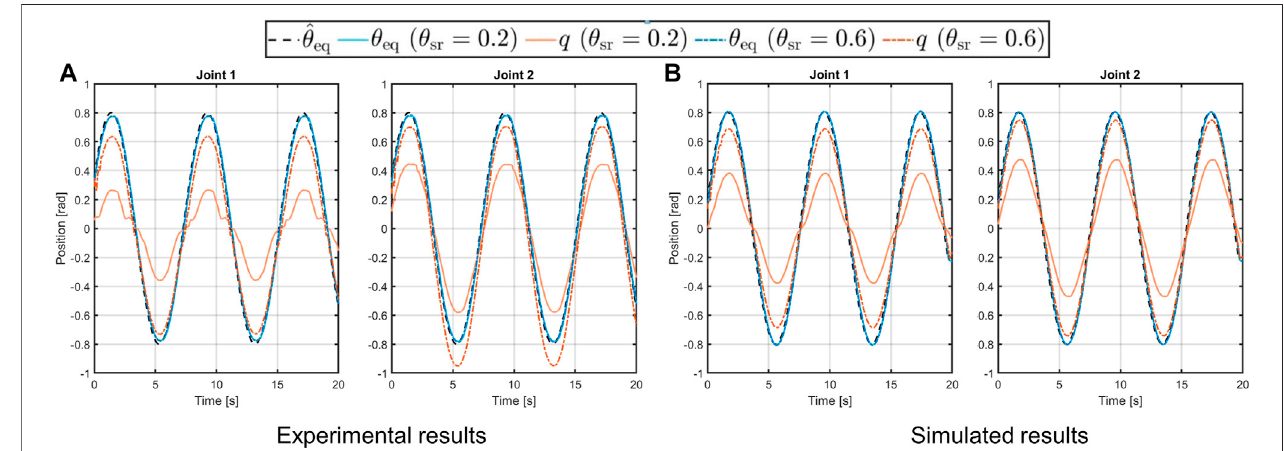
FIGURE14| Experimental and simulatedvalidationsofthestiffness reproduction withtheproposedROS-Gazebotoolboxincaseofaninteraction task withabox of 2 kg weight. The right-hand side fi gures show the behavior in the soft scenario, while on the left-hand side the stiff case is reported. In the former case both the experimental and the simulated platforms are not capable to move the box, while if stiffened they can exert an increased force to the box able to move it forward.